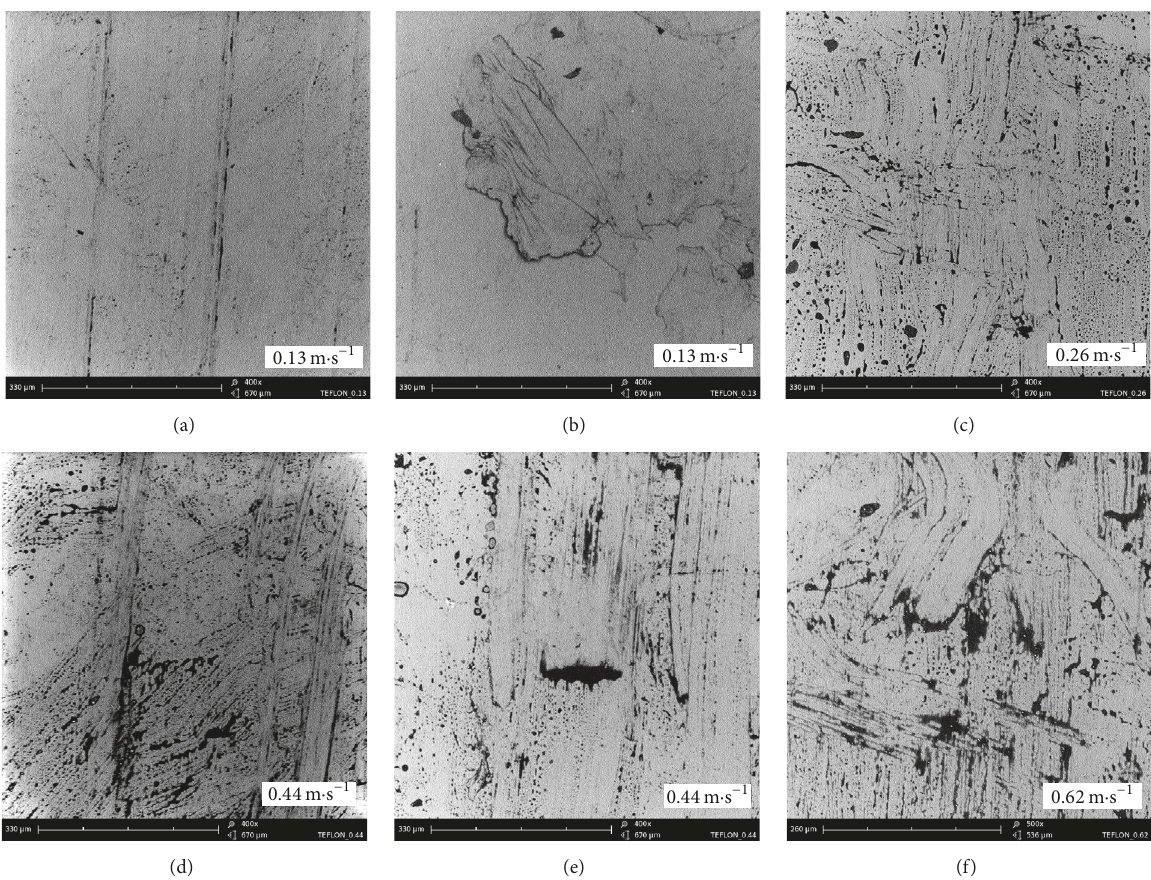
Figure 10: Effect of sliding velocity on worn surfaces of the investigated PTFE: (a) scratches and small discontinuities, (b) plastic deformation, (c) localised worn surface areas, (d) localised worn surface areas and numerous pores, (e) marks of fatigue wear, and (f) localised worn surface areas and numerous pores,